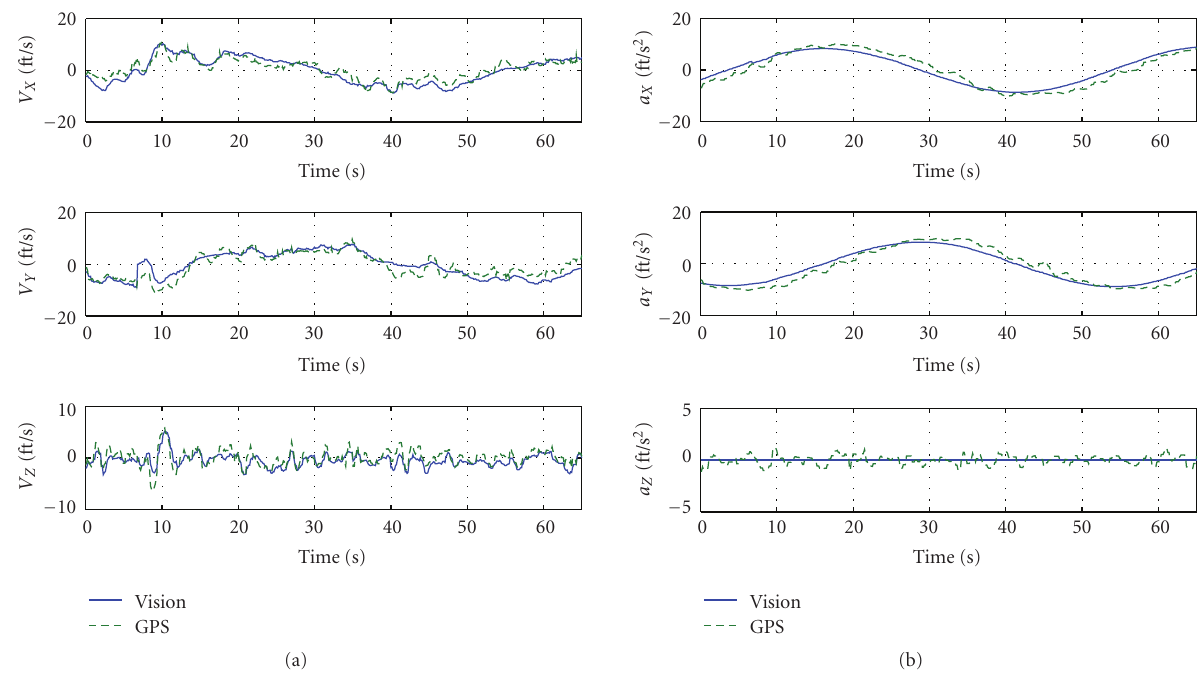
Figure 7: (GTYak-GTEdge) Vision-based versus GPS-based estimated relative velocity (a), and acceleration